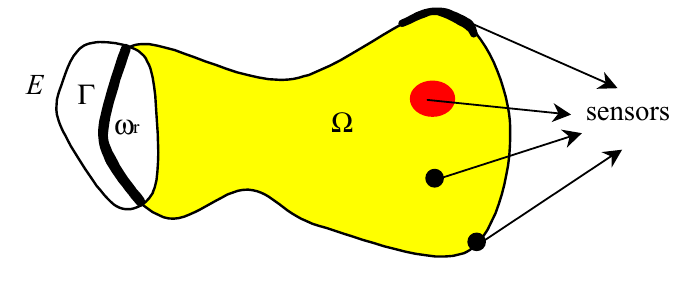
Figure 2: The considered domain Ω and the subregion ω